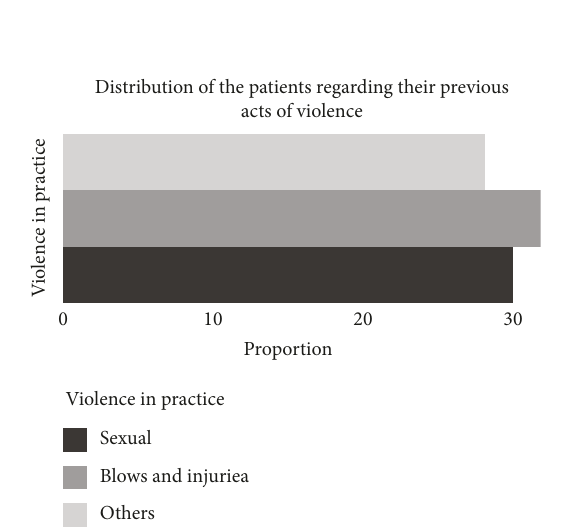
Figure 3: Distribution of the subjects according to their histories of violence.